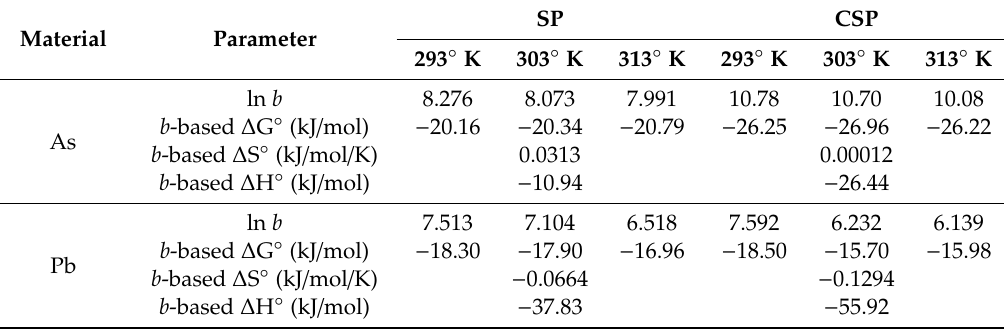
Figure 7. Relationship between 1/T and ln b for ( a ) As and ( b ) Pb. Table 5. Results of thermodynamic analyses for As and Pb adsorption at 293, 303, and 313 K.